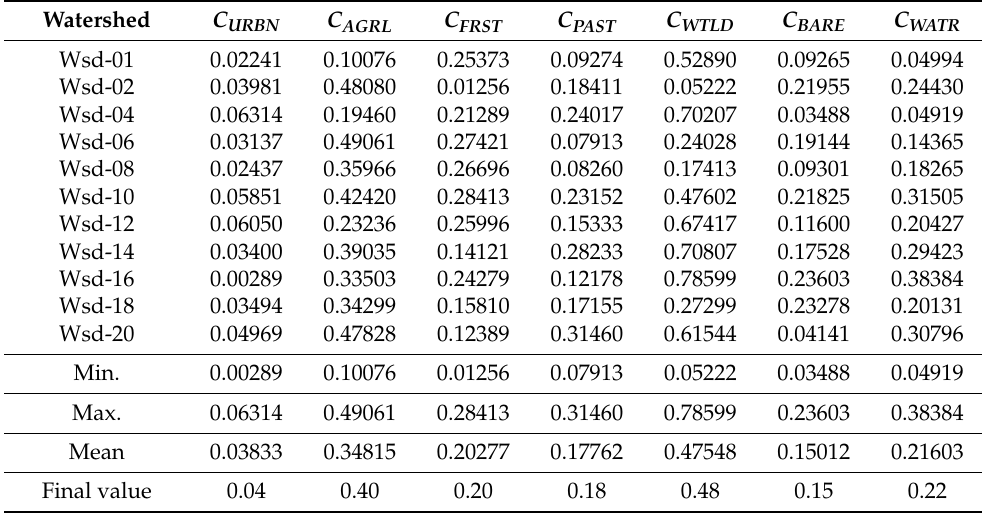
Table 4. Optimized coefficients for the Equation (2).